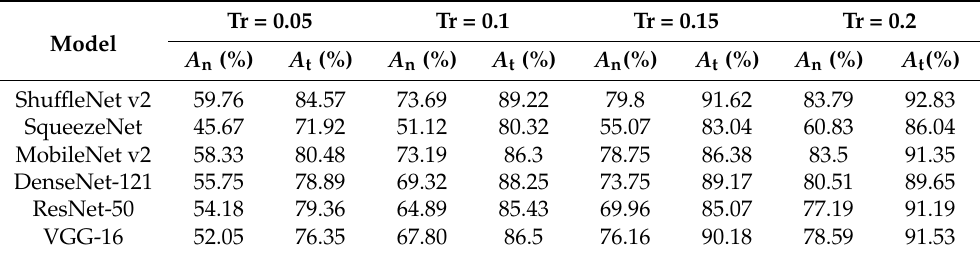
Table 3. Comparison results of various models with different training ratios on AID dataset. Tr is the training data